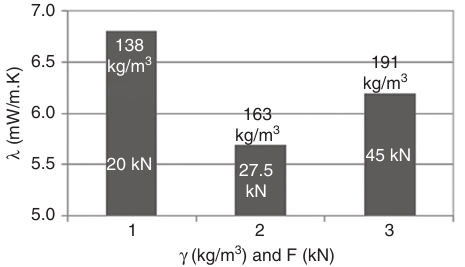
Figure 5 Relationship between core compressive load, mass per volume, and thermal conductivity coefficient of VIP.